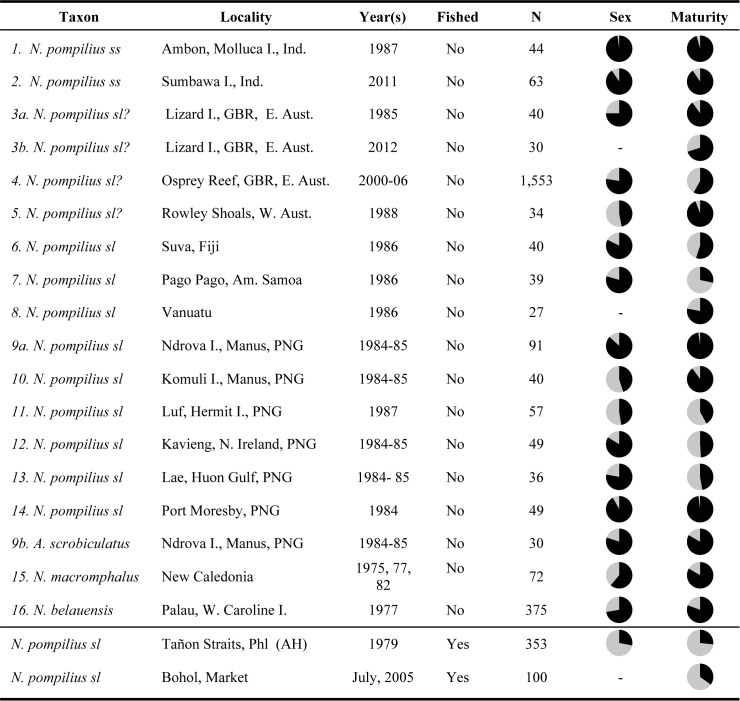
Comparison of sixteen unfished, equilibrium nautiloid populations to a fished, disequilibrium Philippines population reveals significantly higher proportions of males and mature individuals in the equilibrium populations.Demographic data from 16 unfished populations of Nautilus and Allonautilus (2,669 live-caught, tag-release animals) averaged 75% males and 74% mature animals compared to a 1979 sample of overfished N. pompilius (n = 353) from Tañon Strait, Philippines (~28% males and ~27% mature animals). The Philippine fishery crashed in the 1980s. Pie charts show proportion of males and mature animals in black. For additional details see Table A in S1 File.